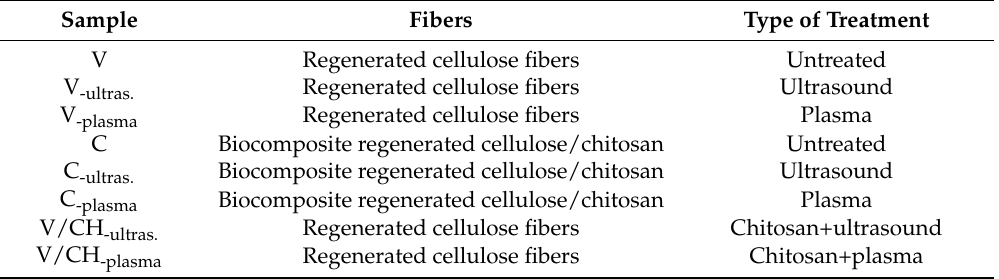
Table 1. Notation of untreated and treated regenerated cellulose and biocomposite regenerated cellulose/chitosan